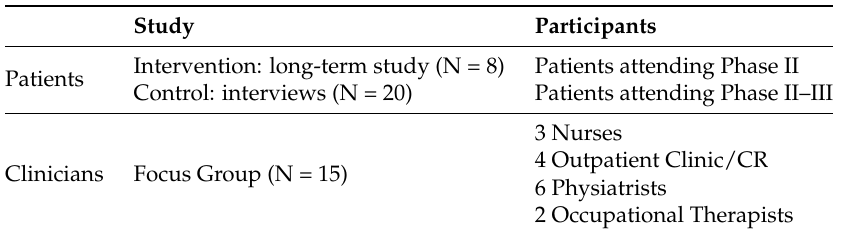
Table 3. Participants in the perception